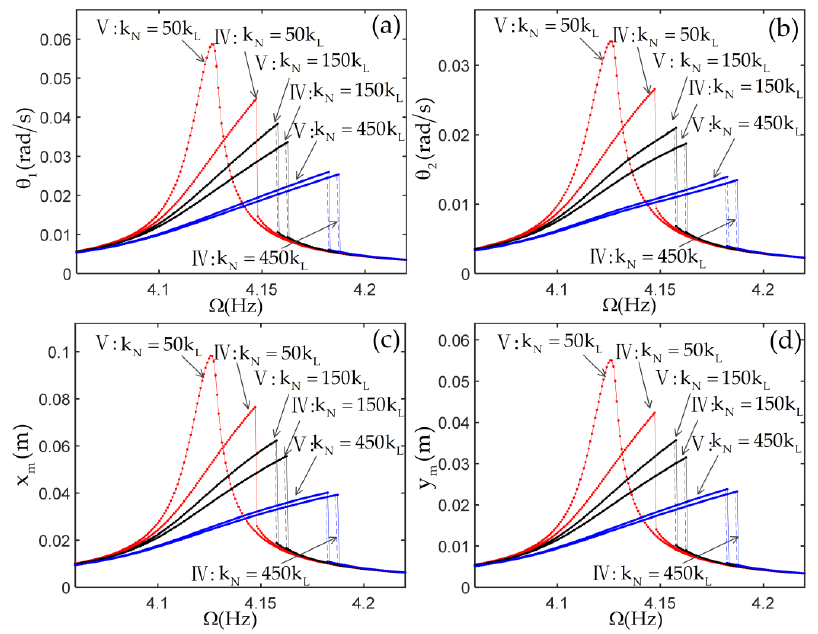
Figure 10. The frequency response curves of the structure with k L = 5EI/L. ( a ) the displacement of first joint; ( b ) the displacement of second joint; ( c ) the horizontal displacement of tip mass; ( d ) the vertical displacement of tip mass;